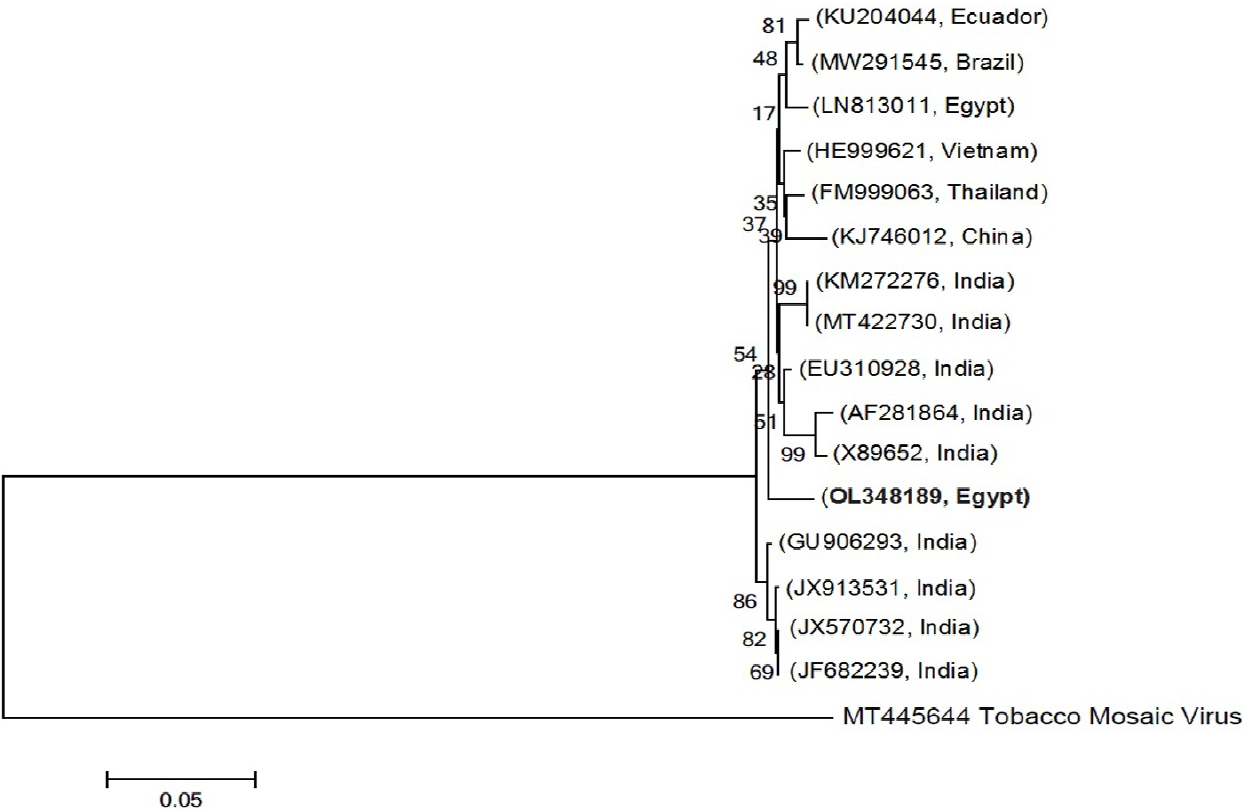
Figure 2. A constructed phylogenetic tree was drawn based on the sequences of the partial coat protein (CP) gene of an Egyptian Cucumber mosaic virus (CMV) isolate (OL348189) and other CMV Cucumber mosaic virus (CMV) isolate (OL348189) and other CMV isolates in GenBank. protein (CP) gene of an Egyptian isolates in